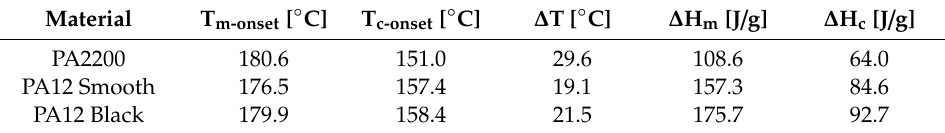
Table 4. Thermal Properties of Powders PA2200, PA12 Smooth, and PA12